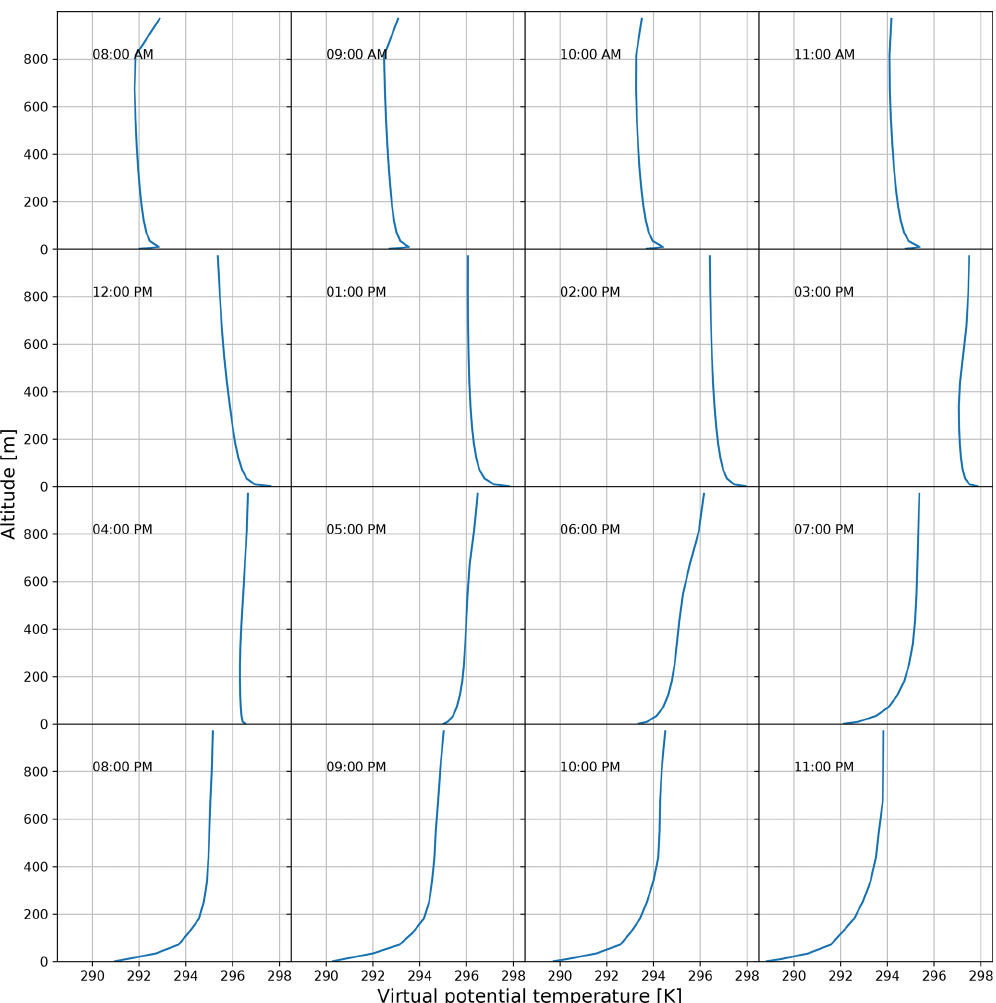
Figure A1. Vertical profiles of the virtual potential temperature along the mean trajectory of Fig.